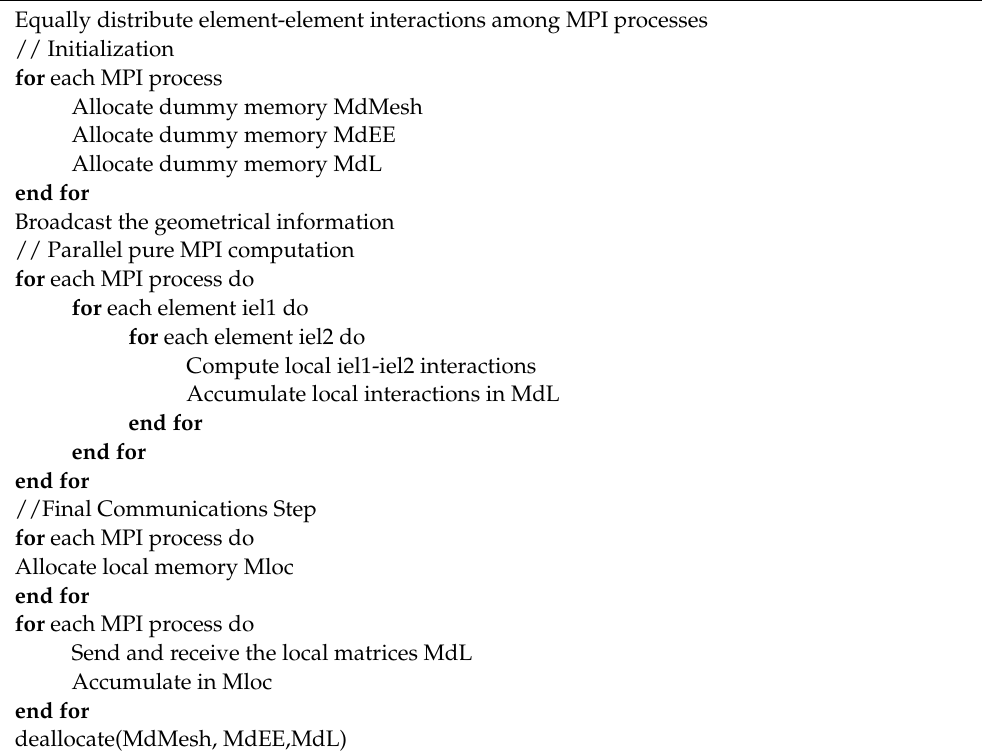
Algorithm 2 Assembly of L matrix, pure MPI